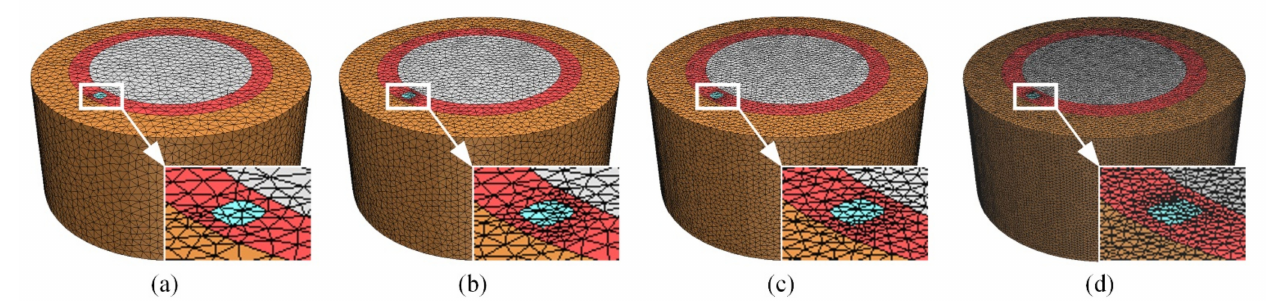
Figure 10. Meshes with different densities: ( a ) medium mesh, ( b ) better mesh, ( c ) fine mesh and ( d ) finer